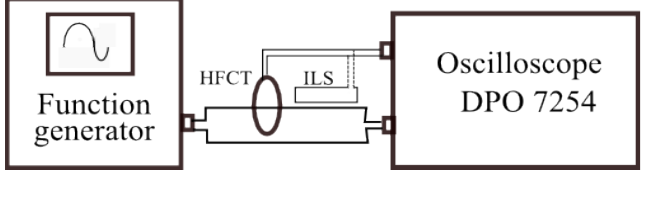
Figure 4. Experimental setups to obtain the frequency response of the sensors: HFCT and